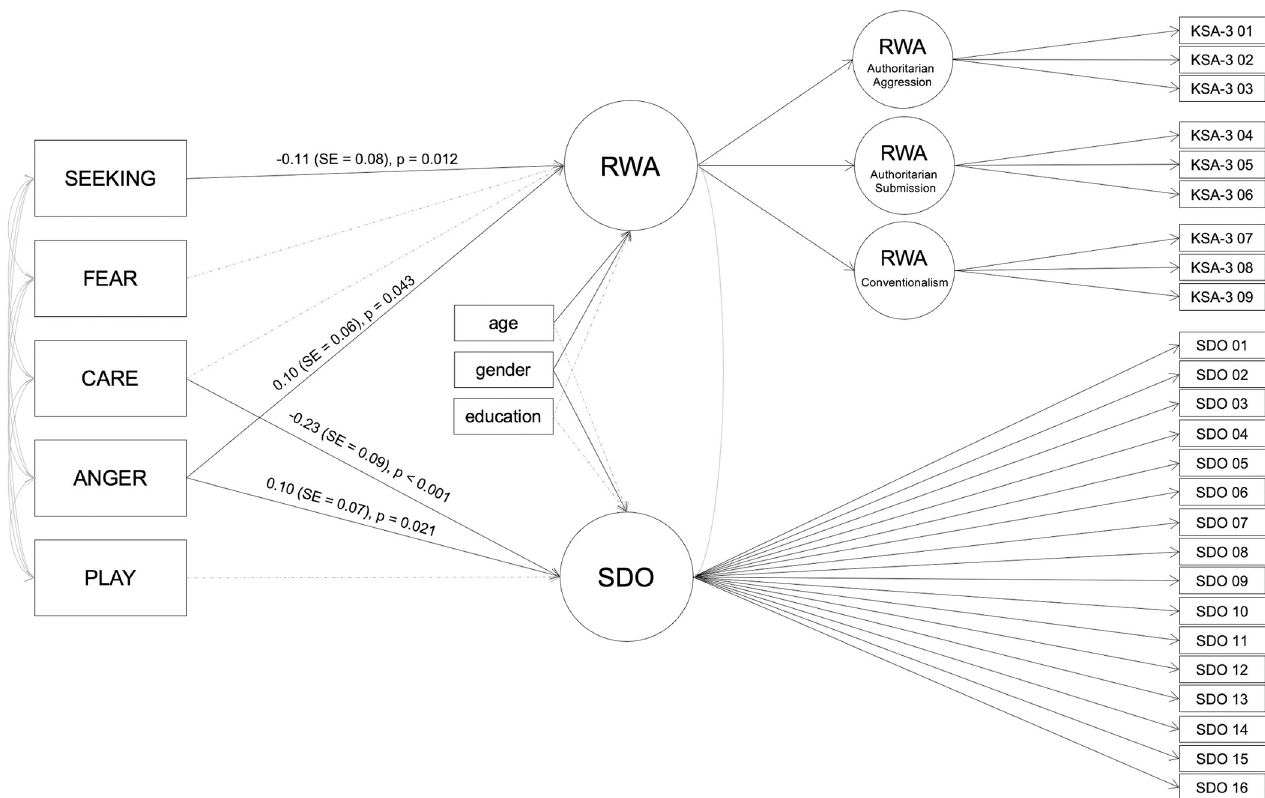
Fig 3. Results of the structural equation model on predicting RWA and SDO by the ANPS scale scores. Dashed lines indicate associations which were modeled but turned out to be non-significant; variances are not included in this figure for easier interpretability; similarly, standardized estimates are only presented for the significant ANPS-RWA/SDO relations for easier